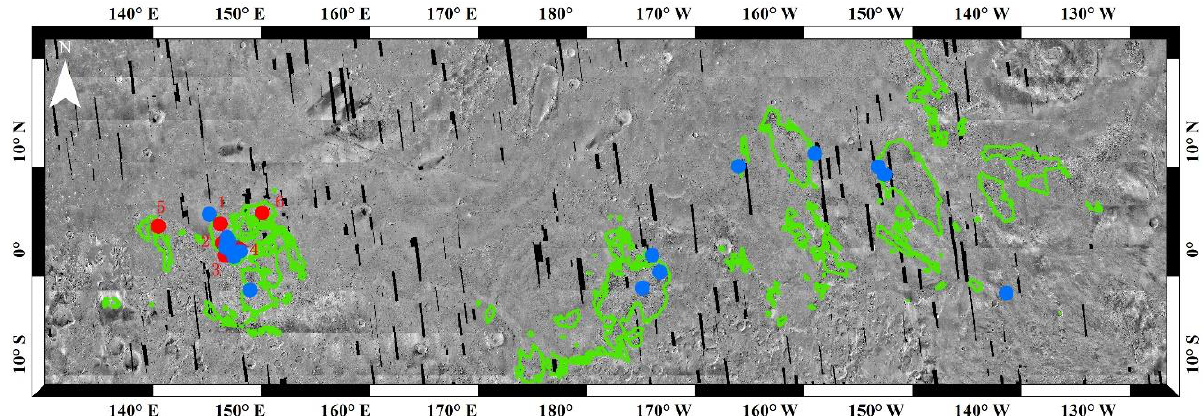
Figure 4. Yardangs (green polygons) in the MFF and the layered ejecta craters (circle points) nearby. Among the 24 layered ejecta craters, only six (red circle points) are selected for dating because their continuous ejecta is not altered by the surrounding yardangs. The yardangs’ locations are from Liu et al. (2020). The image is a CTX mosaic at a resolution of 5 m/pixel.